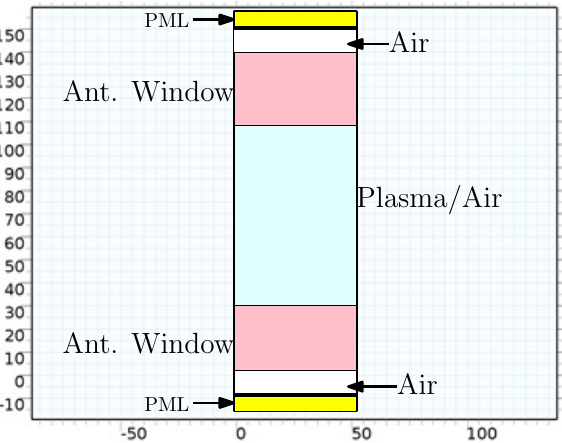
Figure 4. Schematics of the numerical model of the THz propagation in the test